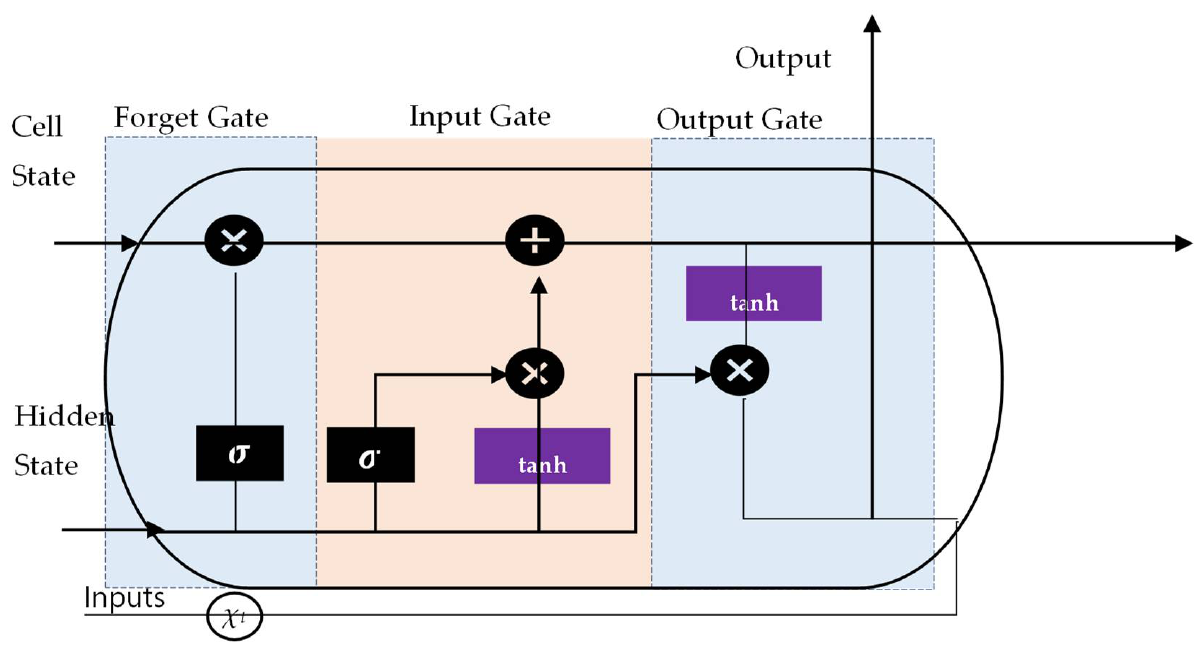
Figure 1. Architecture of LSTM blocks.